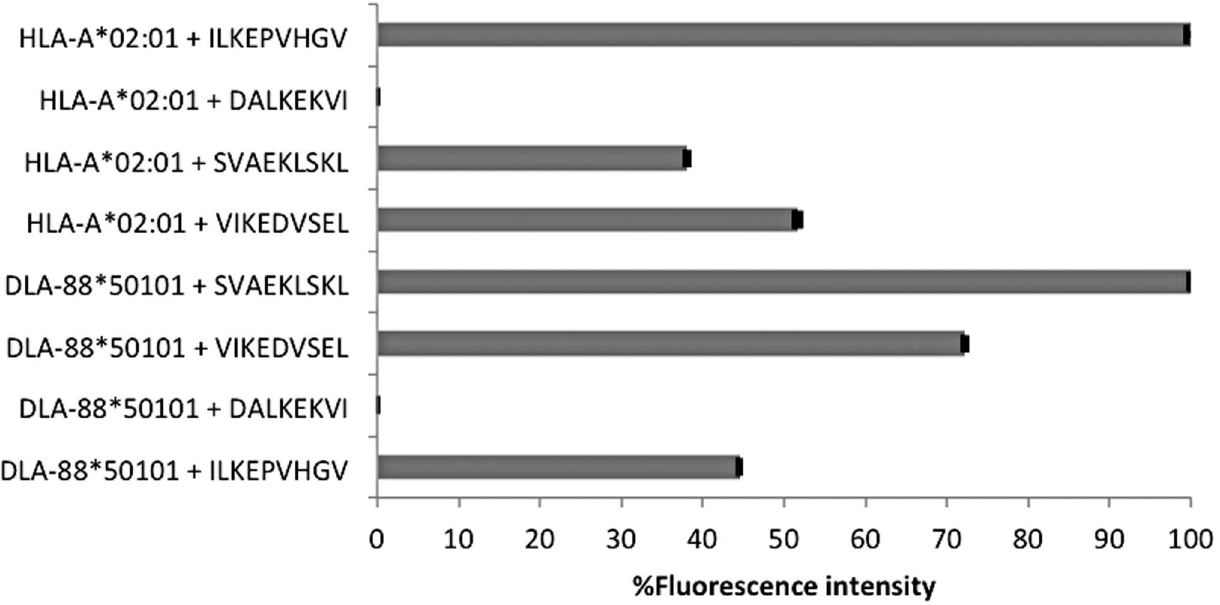
Fig 5. Peptide binding on HLA-A * 02:01 versus DLA-88 * 50101. The cells were incubatedwith peptidespol HIV-1 reverse transcriptase 476–484,ILKEPVHGV; S-adenosylmethioninesynthase 220–227 DALKEKVI; Spatacsin1296–1304SVAEKLSKL and mediatorof RNA polymerase II transcription subunit28110–118VIKEDVSEL for 1 h 30 min at 37˚C in a 5% CO 2 atmosphere. DMSO was used as negative control to determine the intrinsicfluorescence. Sampleswere analyzedby flow cytometry and data derivedfrom two biologicalexperiments and three technicalreplicateswas analyzedas describedin the “Materials and Methods”. The standard deviations of the analyzeddata are shown in bars. For HLA-A * 02:01 loading,the fluorescence intensity of peptidebindingregardingILKEPVHGV on HLA-A * 02:01 was set to 100%, whereasfor DLA-88 * 50101loading,SVAEKLSKL bindingon DLA-88 * 50101 was set to